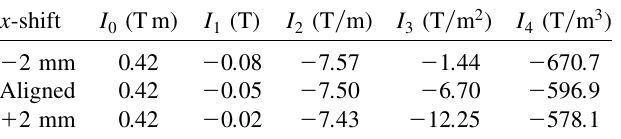
expansion as a function of the beam-wiggler misalignment in the central semiperiod.